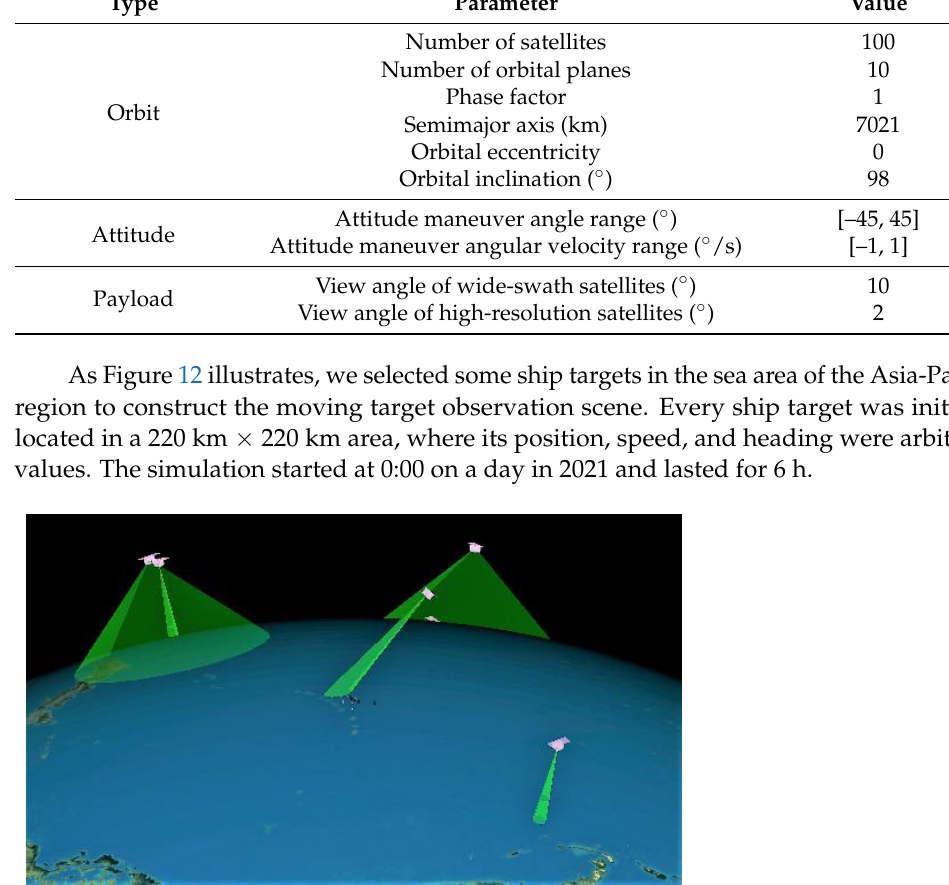
Figure 12. Moving target observation scene.